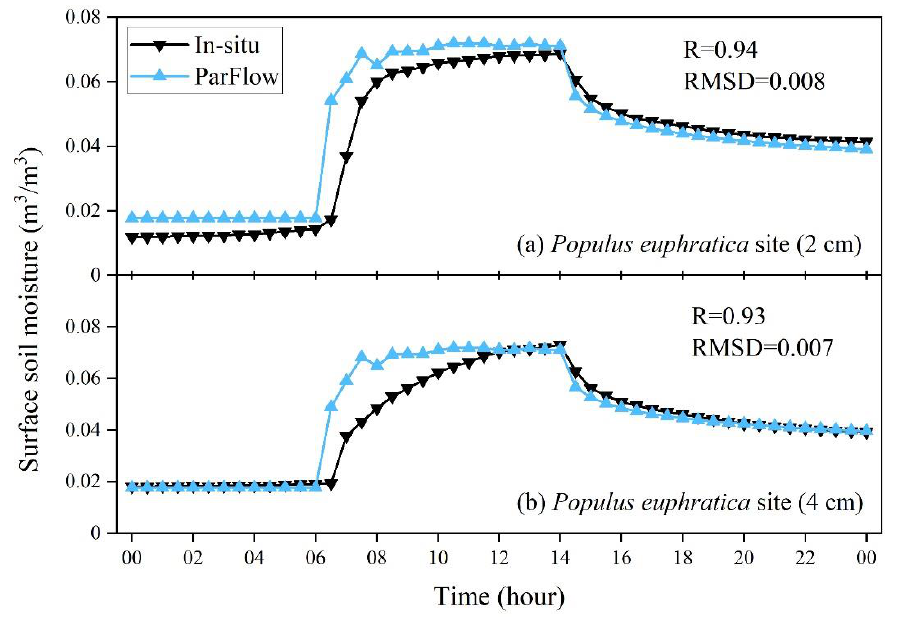
Figure 13. Surface soil moisture time-series comparison between ParFlow simulation and observation at the Populus euphratica site on 3 September 2015 for the BJH case: ( a ) 2 cm; ( b ) 4 cm. In addition, vertical saturation distributions at four different horizontal positions (x = 1 m, 28 m, 56 m, 85 m) are also drawn in Figure 14 at an interval of 1-h (same as the simulation timestep). Colors are set to represent instantaneous moments from 00:00 (red) to 24:00 (purple). From the variations of vertical saturation hydrographs, we can identify vertical saturation responses controlled by the combined impact of the rainfall rate, evaporation, water table variation and terrain. Before the rainfall event, patterns of all profiles that responded to the evaporation are almost the same. The degree of saturation during the rain period is regulated by the infiltration rate. After the rainfall event (from 17:00 to 24:00, purple lines), distributions of saturation profiles begin to be stabilized, which is depicted by the soil moisture distributions as well. As shown in the vertical saturation hydrograph at x = 1 m, infiltration cause saturation from the top to groundwater table depth. Soon after the rainfall event, unsaturation occurs at the land surface due to the evaporation and distributions of saturation profiles begin to be stabilized. Saturation profiles at x = 28 m and x = 56 m shares a similar pattern but still can be distinguished at the beginning of the cessation period. This phenomenon is caused by the slope impact, which controls the lateral flow. However, these two sets of saturation profiles show different patterns to saturation profiles on the boundaries (x = 1 m and x = 85 m) due to the configuration of variable water tables. At the x = 28 m position, the evolution of saturation profiles is nearly the same as that at x = 1 m, except for periods of the start of the day and drainage. We believe this is probably due to the combination of water table variation and terrain impacts.